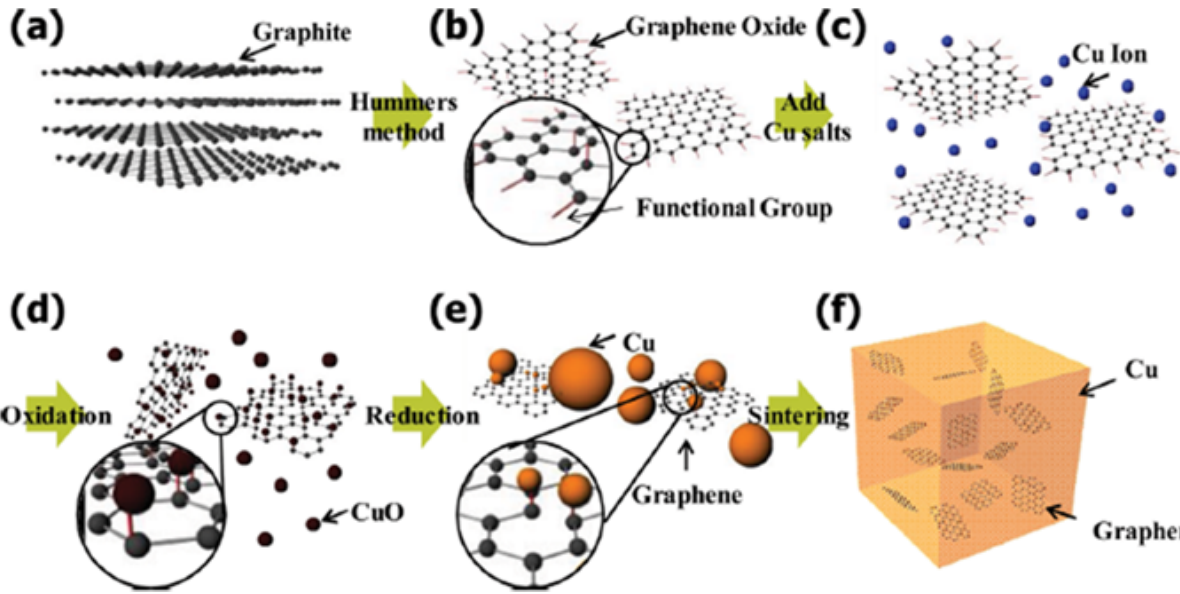
Figure 10: Schematic of the MLM process to fabricate rGO-Cu composite. (a) Graphite. (b) Graphene oxide prepared by Hummer’s method. (c) Dispersion of Cu salt in GO solution. (d) Oxidation of Cu ions to CuO on GO. (e) Reduction of GO. (f) Sintered rGO-Cu composite powders. Reproduced from Reference